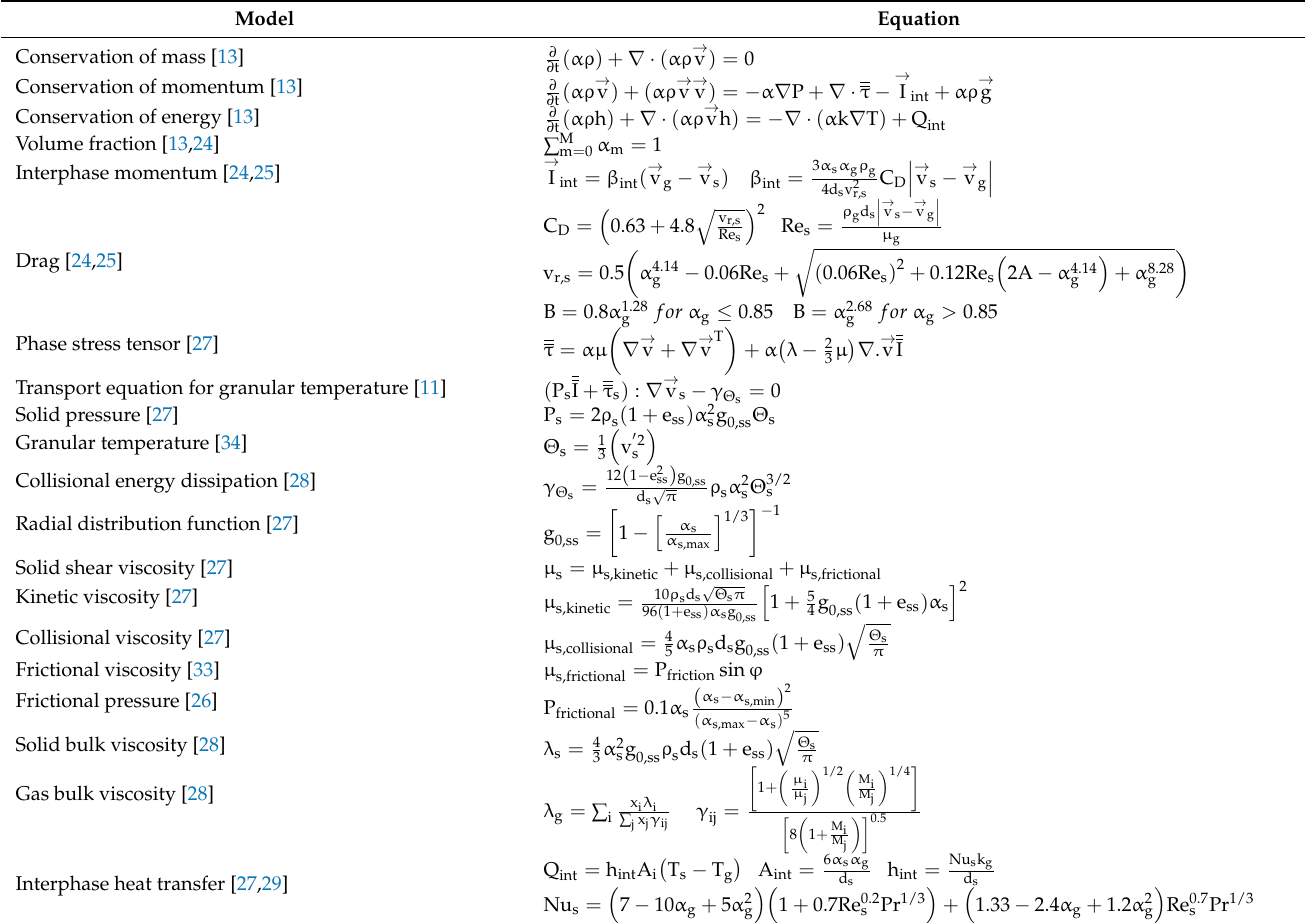
Table 3. Models and